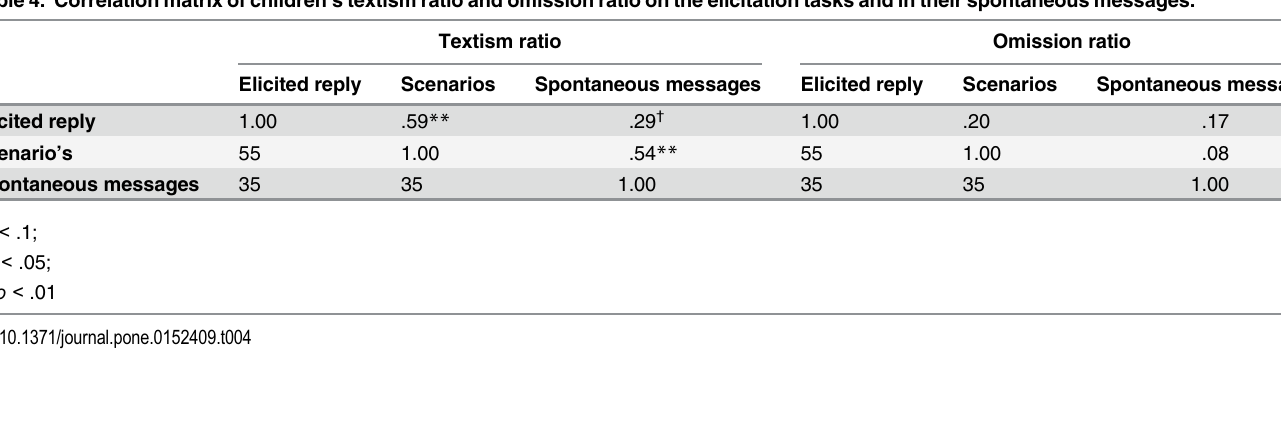
Table 4. Correlation matrix of children ’ s textism ratio and omission ratio on the elicitation tasks and in their spontaneous